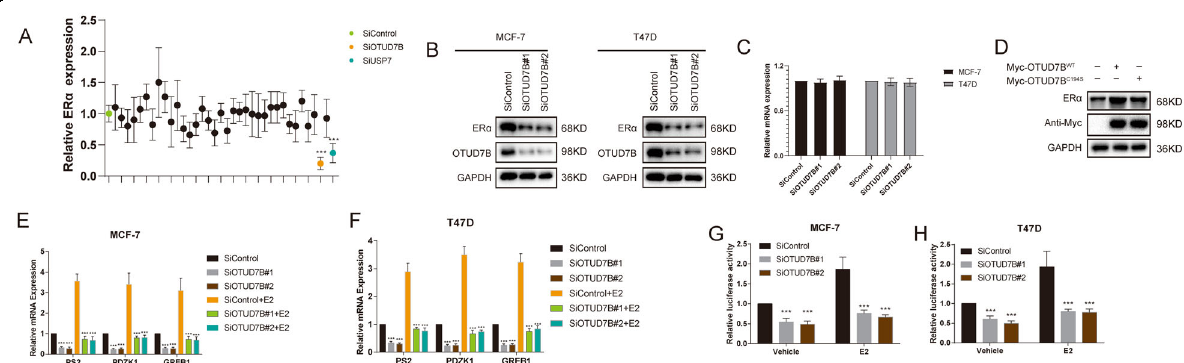
Fig. 1 OTUD7B depletion decreases ER α signaling activity in breast cancer cells. A The siRNAs speci fi c to each deubiquitinating enzyme were transfected into MCF-7 cells. After 48 h, cells were lysed and the ER α protein level was analyzed by Western blot. Relative ER α protein level was normalized to GAPDH. B OTUD7B depletion decreased ER α protein level. C OTUD7B depletion did not affect ER α – mRNA level. D OTUD7B WT or C194S was transfected into MCF-7 cells and ER α expression was detected. E , F OTUD7B depletion decreased ER α target genes in the absence or presence of estrogen. Breast cancer cells were transfected with siOTUD7B or siControl. After 48 h, cells were treated with either ethanol or 10 nM estrogen for 6 h. Total RNA was prepared, and the expression of the endogenous ER α target genes, PS2, GREB1, and PDZK1, was determined by qRT- PCR. G , H OTUD7B depletion affected ERE-luciferase activity. Breast cancer cells were transfected with siOTUD7B or siControl together with ERE- luciferase reporter plasmid. Cells were treated with 10 nM estrogen or vehicle. Luciferase activity was measured 48 h after transfection. * P < 0.05, ** P < 0.01, ***P <